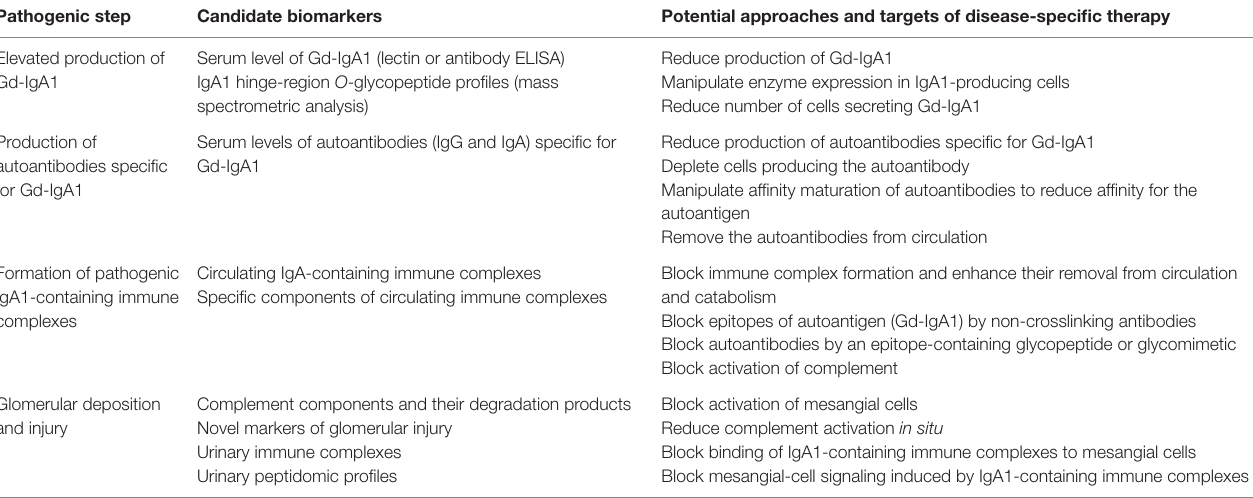
TABLe 2 | Candidate biomarkers and disease-specific approaches for treatment of igAN. Pathogenic